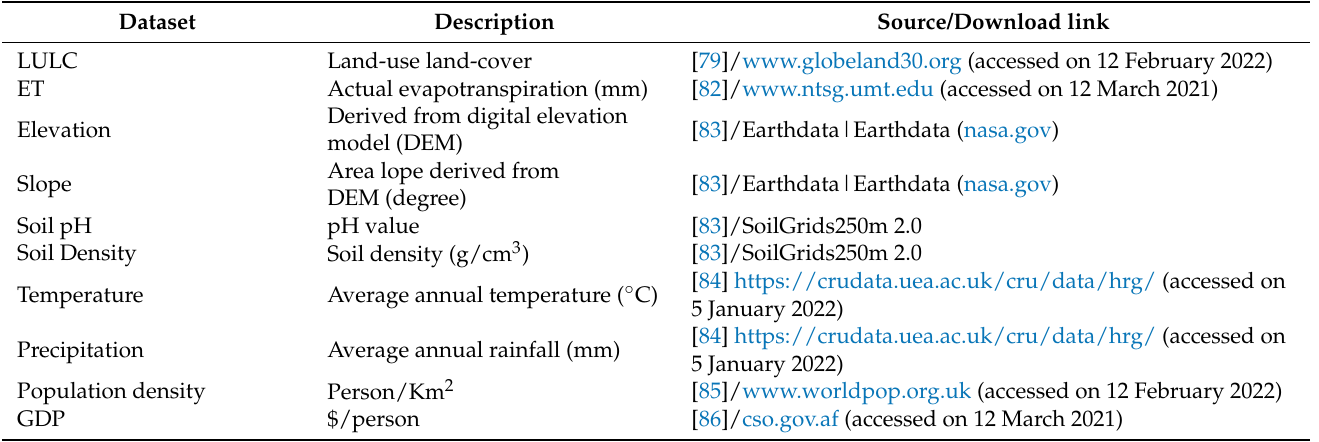
Table 1. Description of the datasets used in this